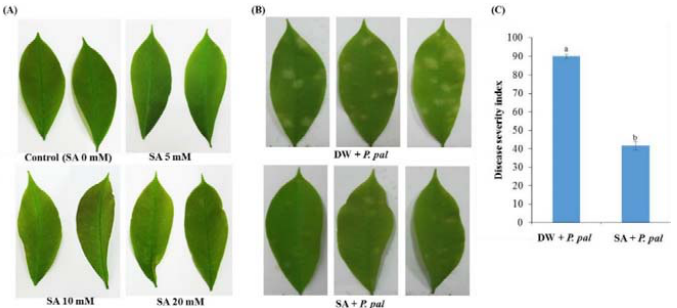
Figure 1. Effect of exogenous SA treatment on rubber tree against P. palmivora. ( A ) Physio-morphological traits of rubber tree leaves at 1 day after treatment with SA at different concentrations of 0, 5, 10 and 20 mM; ( B ) Disease symptom; and ( C ) disease severity (%) of rubber tree leaves pretreated with either DW or 5 mM SA for 1 day prior to subsequent inoculation with P. palmivora zoospore suspensions (1 × 10 5 zoospores mL − 1 ) at 4 dpi. The columns and vertical bars represent means ± standard errors (SE) of three independent replicates of 10 seedlings. Pretreated plants and non-pretreated control differ significantly at p ≤ 0.05, according to paired-samples t -test. All leaves were detached from the seedlings at 4 dpi for better pictorial representation.